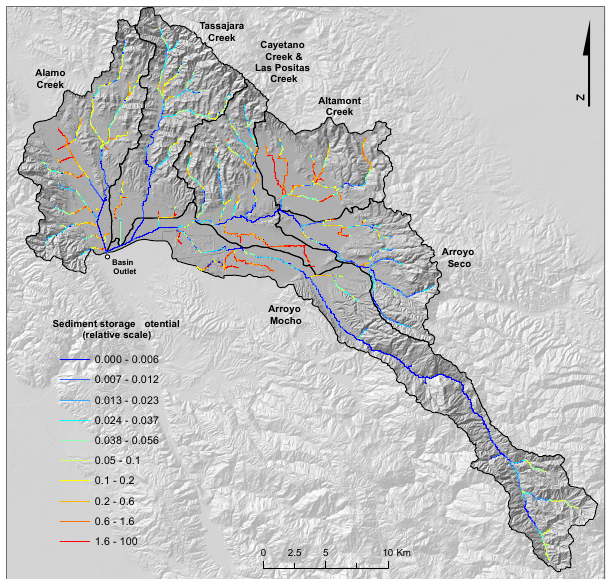
Figure 10. Estimated relative sediment storage potential for main- stem channels (draining areas>2km 2 ) based on valley width index and stream power (see text).